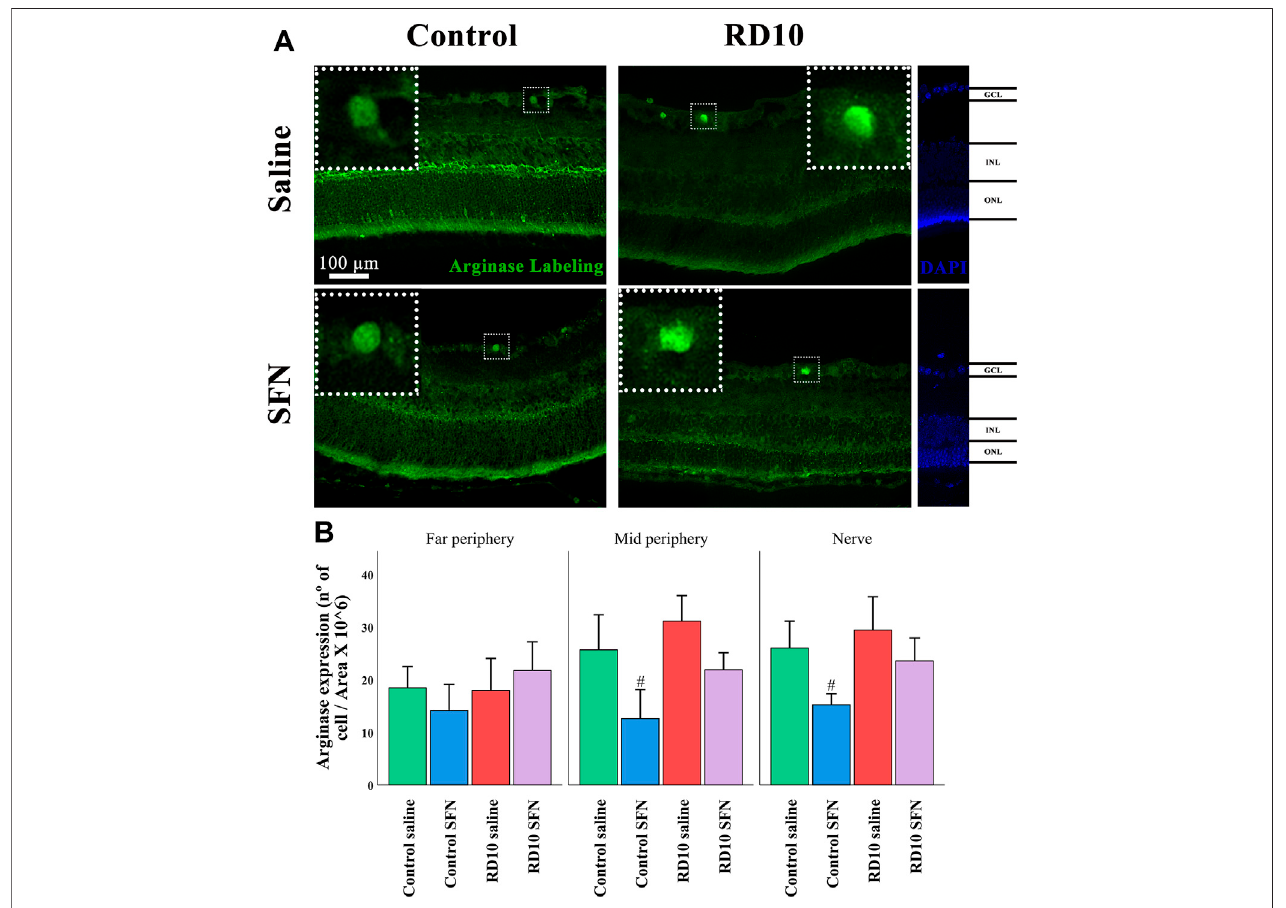
FIGURE 12 | Arginase expression assessment. (A) Nerve region images of arginase immuno fl uorescence of the different groups in the experiment; white arrows point out the positive mark. (B) The number of arginase-positive cells was divided per area and multiplied by 10 6 . #Differences between Control Saline vs. Control SFN ( p -value <